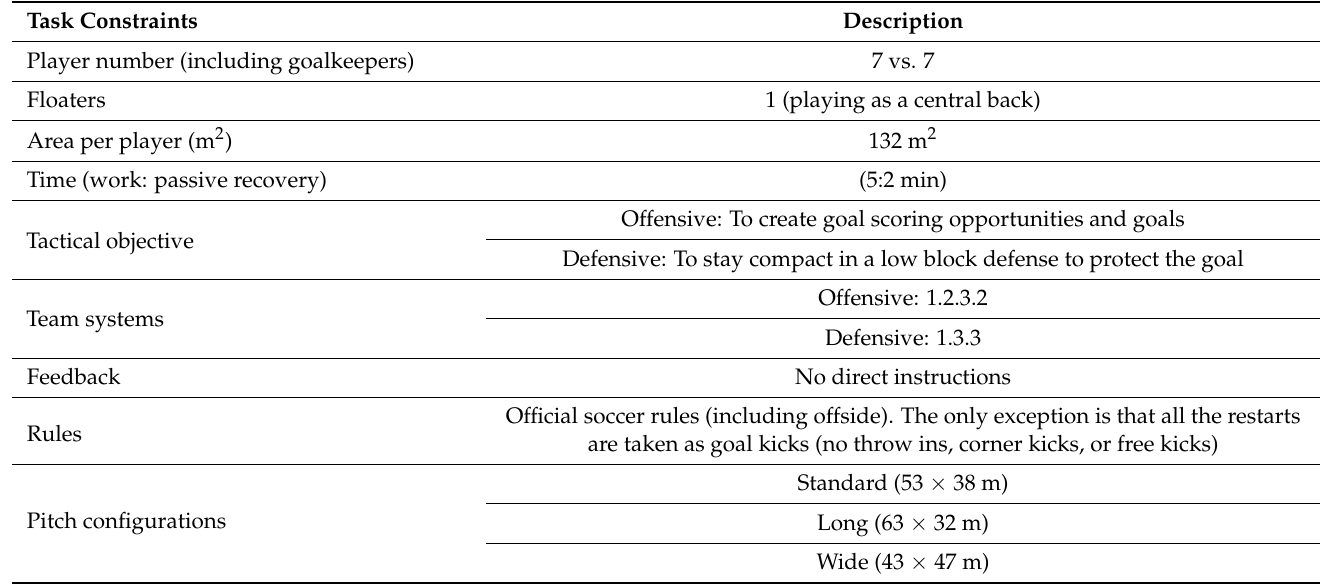
Table 1. Design of the small sided